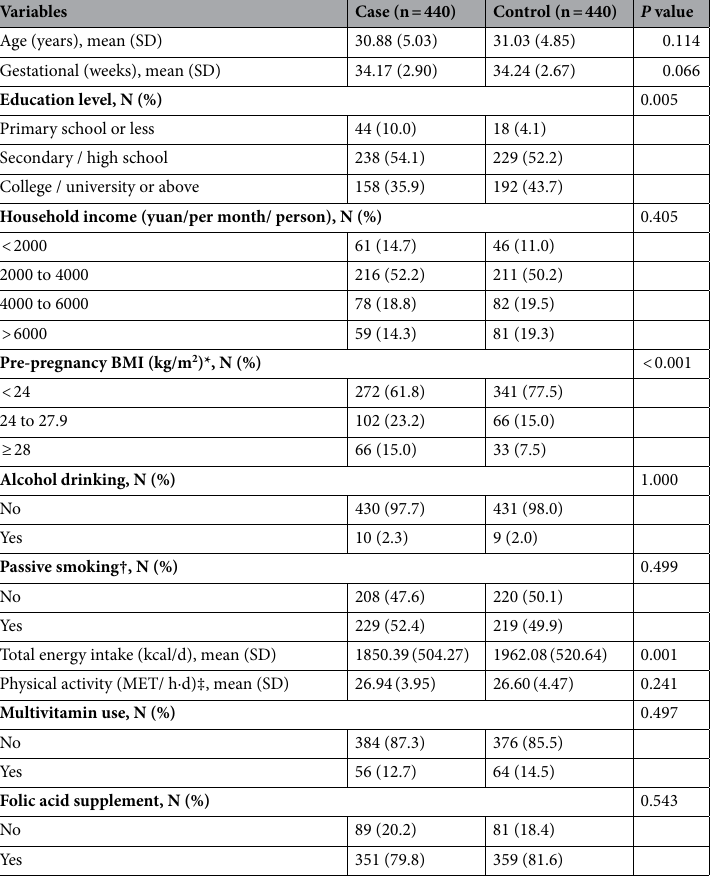
Table 1. Demographics, lifestyle characteristics, and select preeclampsia risk factors among pregnancy women. Abbreviation: SD, standard deviation; BMI: body mass index. *: BMI of gestational age of 28 weeks or more. † : Passive smoking refers to the husband smokes near the pregnant woman in the first three months of pregnancy. ‡ : Physical activities included daily occupational, leisure-time and household-chores, evaluated by metabolic equivalent (MET) hours per day. Continuous variables were described by mean (SD), evaluated by t-tests; Categorical variables were described by number (%), evaluated by chi-square tests.